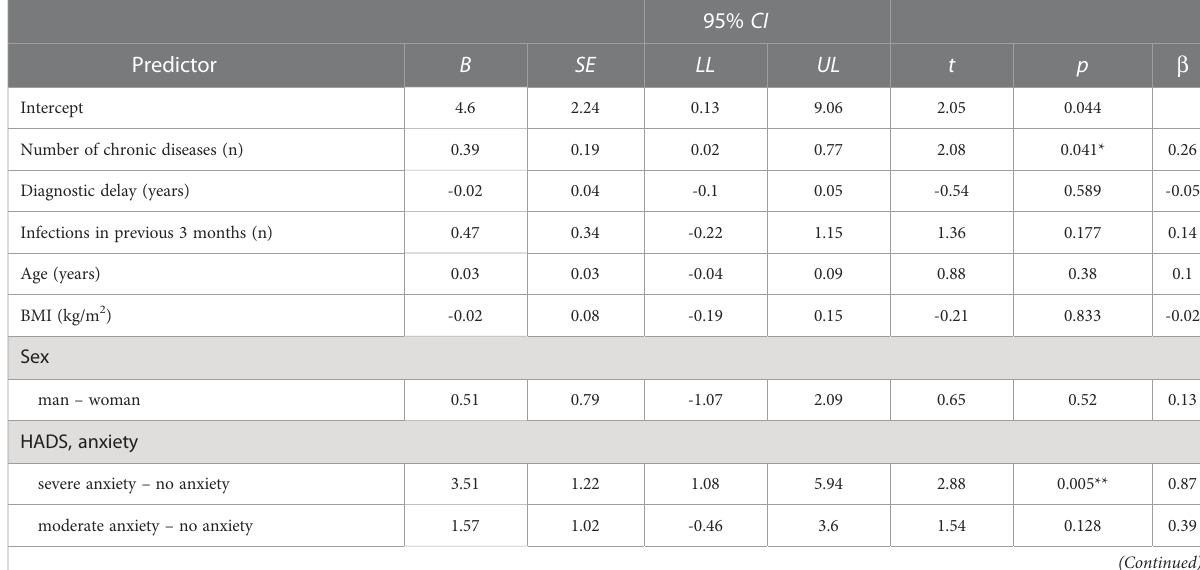
TABLE 9 Multiple linear regression model for